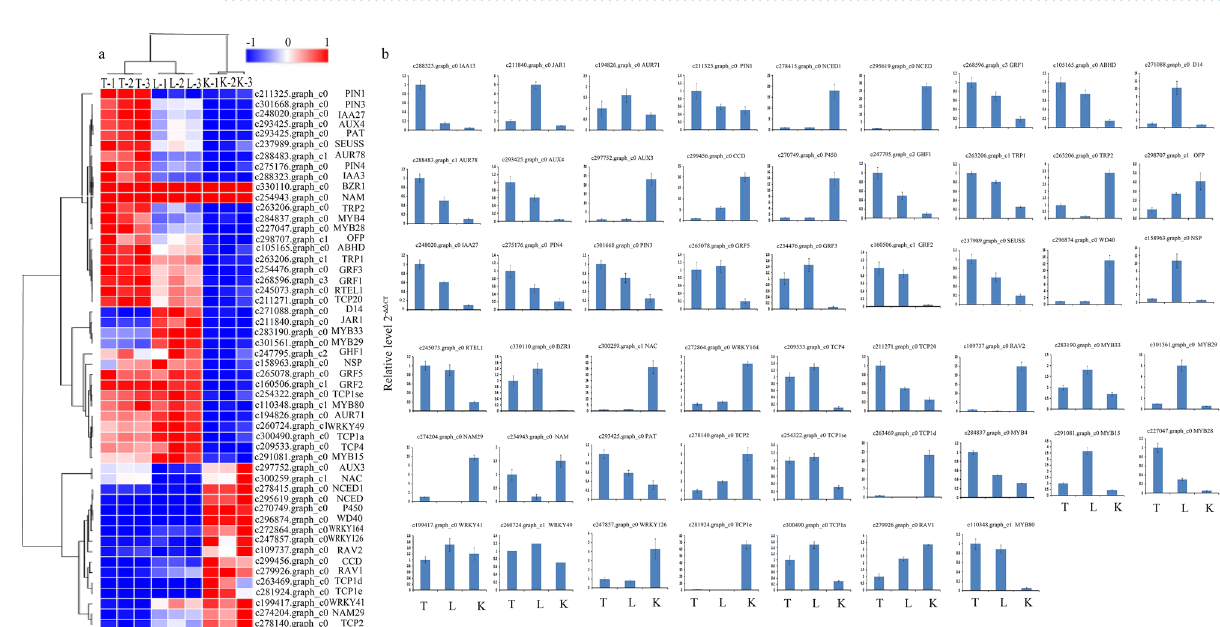
Figure 7. Real-time PCR validations of 52 candidate DEGs in different material. ( a ) Heat map of 52_DEGs. Different column represented disserent samples and different rows represented various genes. ( b ) qRT-PCR of 52_DEGs. The Y-axis represents the relative expression, and the X-axis depicts the different insect resistance material. The standard error of the mean for three biological replicates is represented by the error